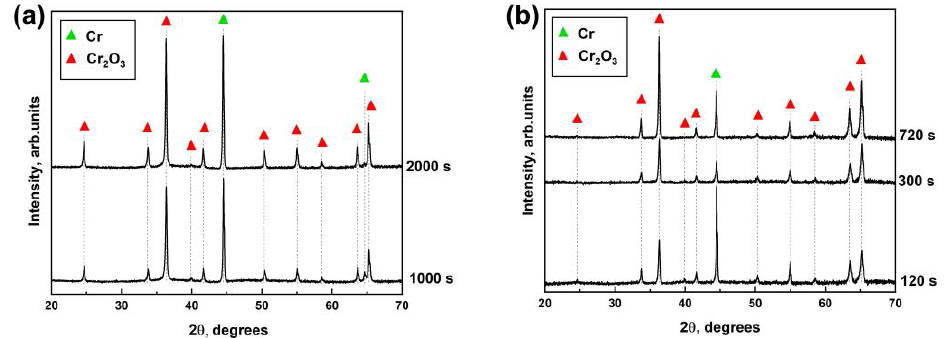
Figure 2. Diffraction patterns of the Cr/Mo-coated samples after oxidation at 1200 ◦ C ( a ) and 1330 ◦ C ( b ).